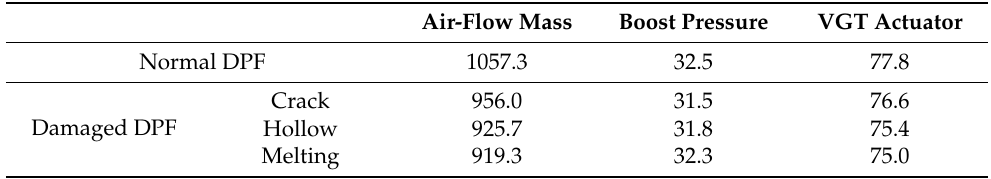
Table 7. Maximum value of three GDS parameters related to air